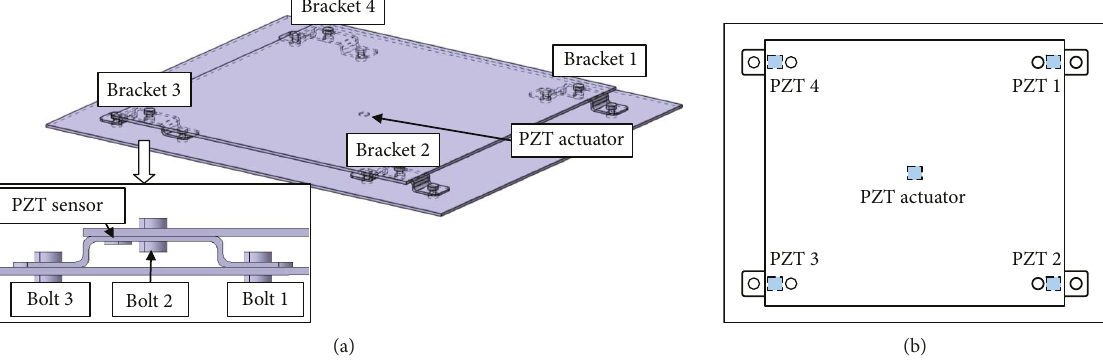
Figure 4: A schematic of the simulated PTS panel: (a) the simulated PTS panel and its brackets and (b) relative locations of the PZT transmitters. Table 1: Bolt loosening conditions for each bracket.